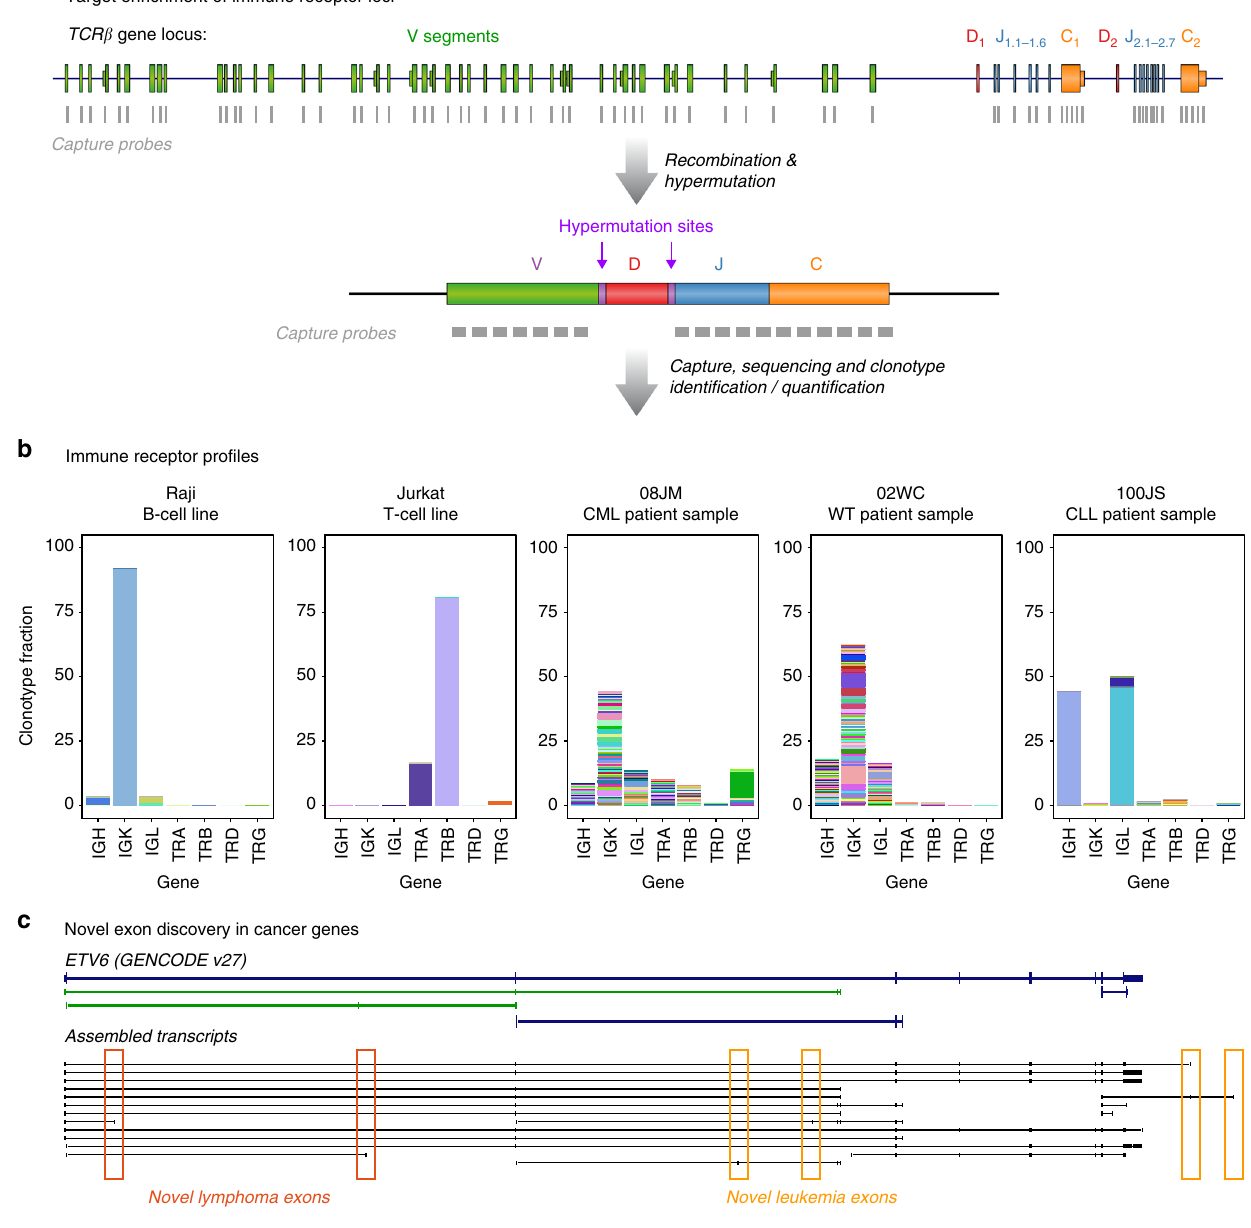
Fig. 5 Novel fi ndings in transcriptomic analysis. a Schematic of immune receptor capture probe design across the T cell receptor β (TCR β ) locus and a transcript expressed post-V(D)J rearrangement. b Immune receptor clonotypes in cell lines and clinical patient samples quanti fi ed using MiXCR. Each colour represents a single clonotype. c Novel ETV6 exons shown underneath GENCODE v27 annotation. Red arrows indicate exons found in lymphoma samples, blue arrows indicate exons found in leukaemia